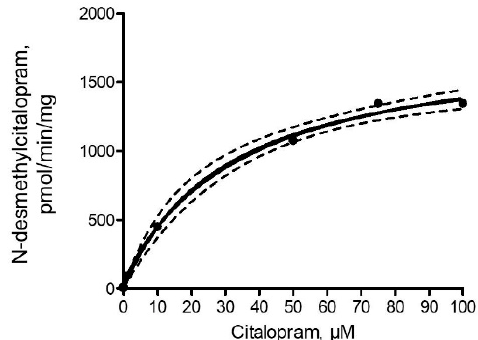
Figure 1. Saturation curve for N -desmethylcitalopram formation from citalopram in S9 fractions from the liver of common carp ( n = 12 in 3 pools with equal sex ratio). The dashed line indicates a 95% confidence level of the best-fit curve.